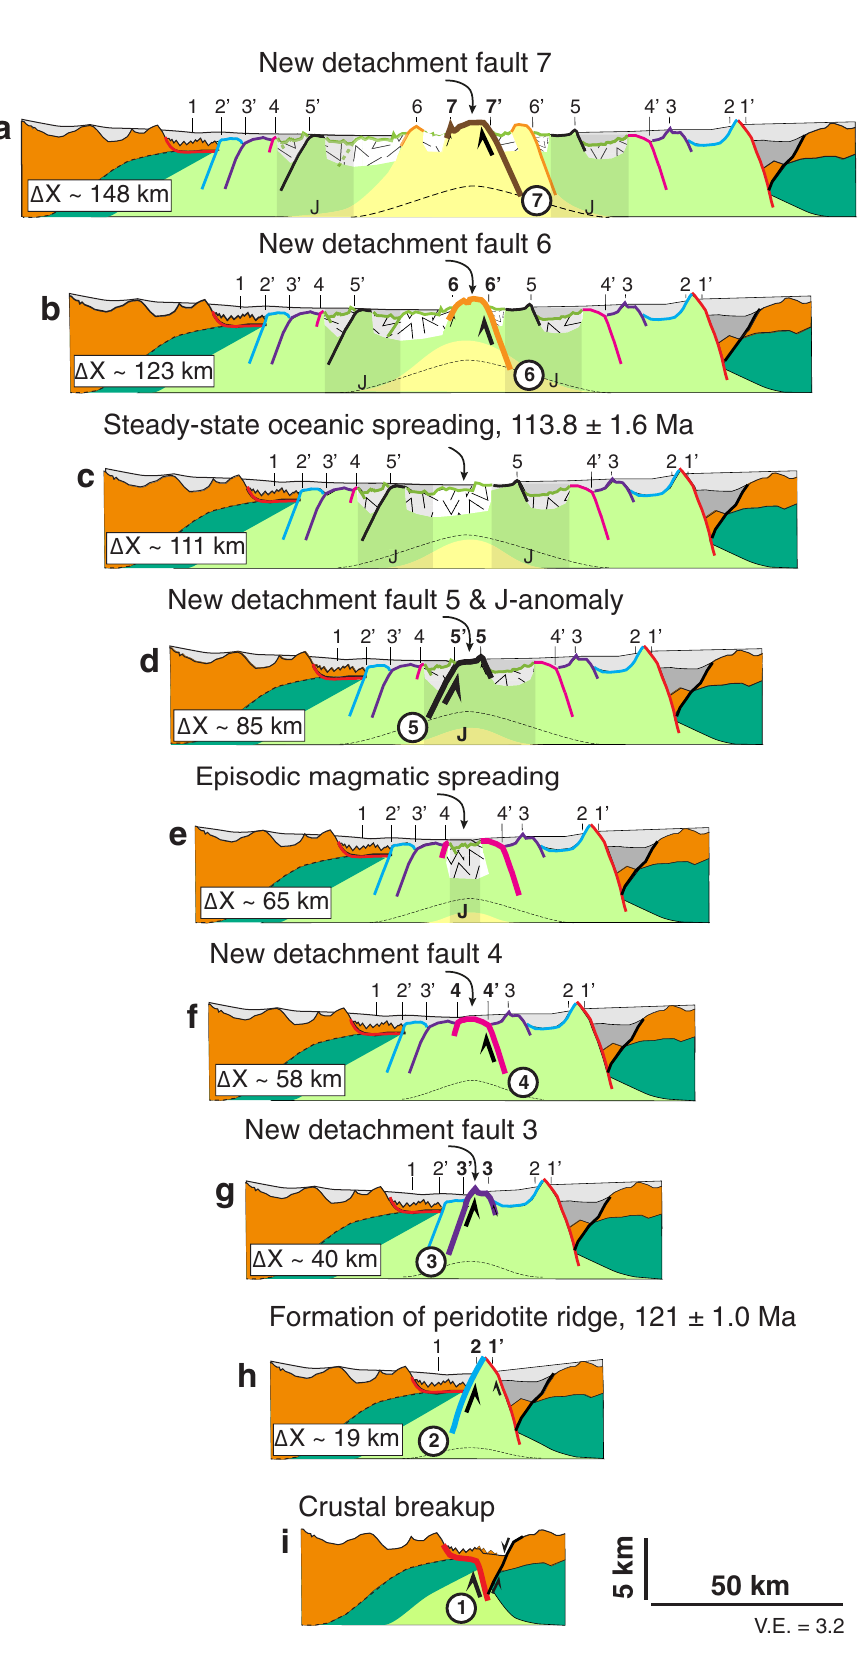
Fig. 6 Kinematic reconstruction of the conjugate seismic pro fi les SCREECH-1 and ISE-1/WE-1. a , b Final stage of mantle exhumation with the formation of detachment fault 6 and 7 during mature mid-ocean ridge spreading. c Onset of magmatic spreading with the accretion of thin oceanic crust with smooth basement morphology. d Formation of detachment fault 5. e Episodic magmatic activity resulting in the accretion of thin oceanic crust and smooth basement morphology and formation of J anomaly. f , h Successive formation of detachment faults 2 – 4. i crustal breakup and formation of fi rst peridotite ridge at